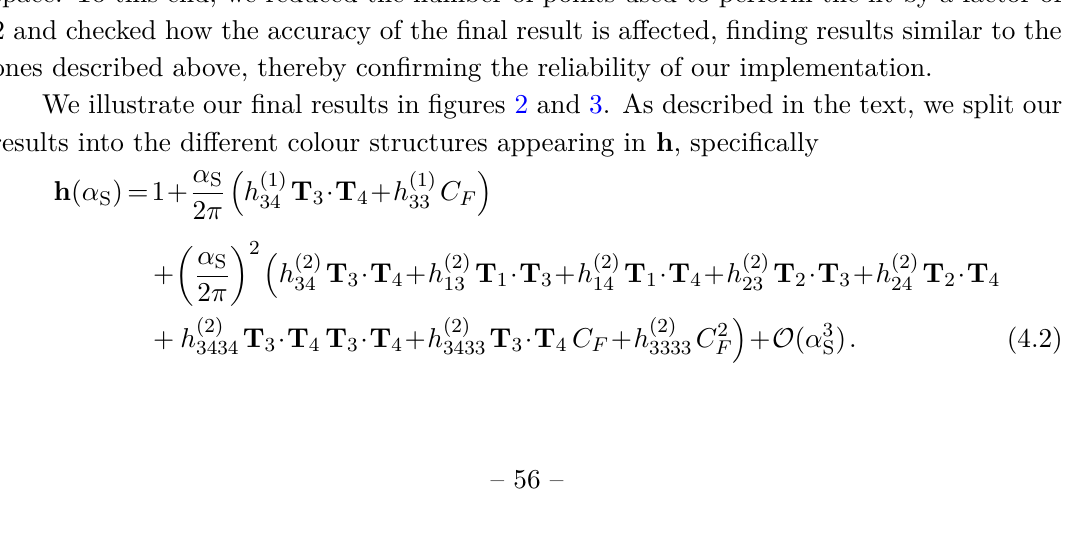
= 0 . The left panels show the β dependence f